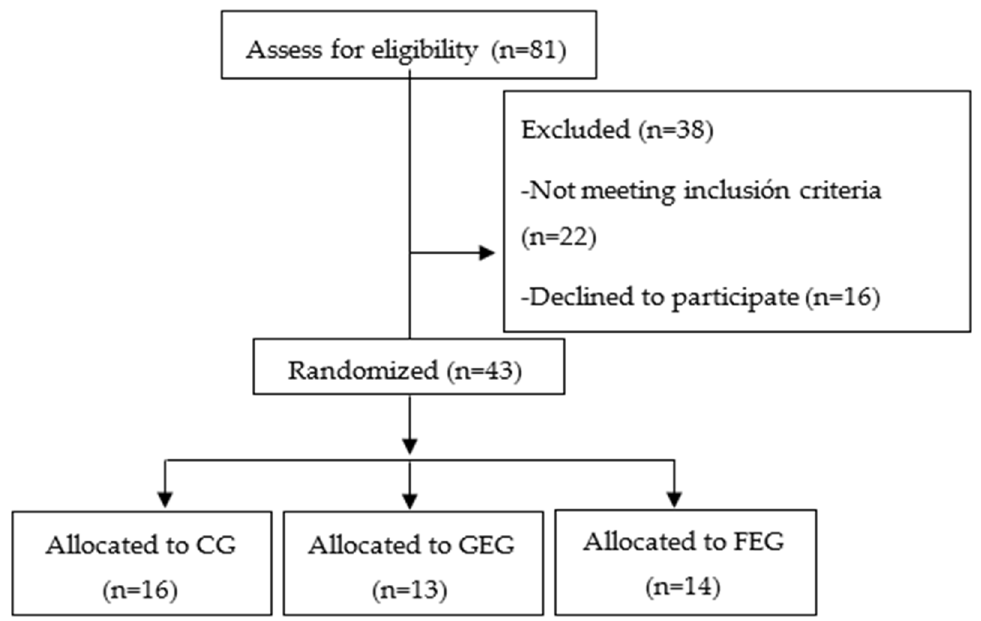
Figure 1. Flow chart.